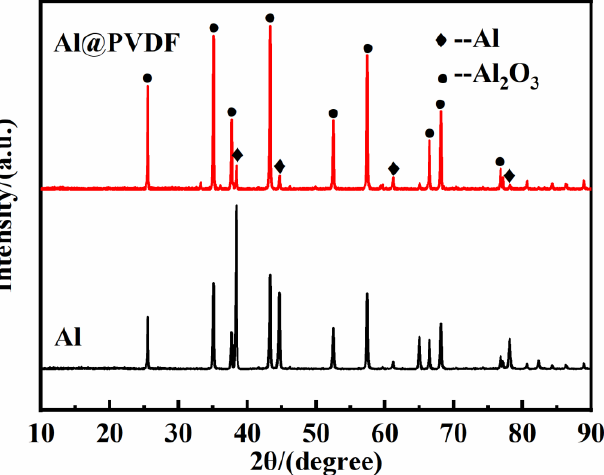
Figure 7. XRD patterns of oxidation products at 1300 °C. The products were recovered from TG-DSC analysis.